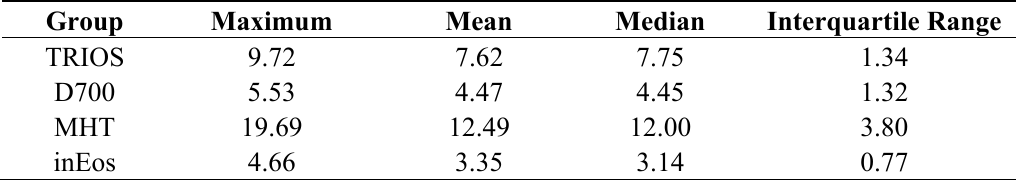
Table 1. RMS analysis of precision for each scanner ( μ m).